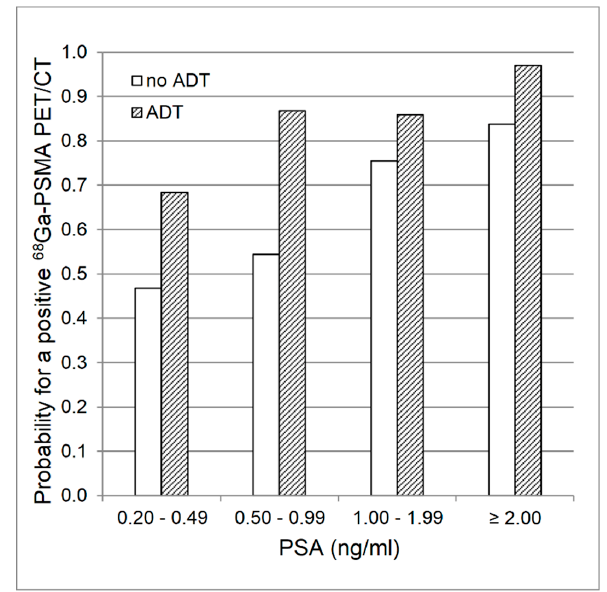
Figure 1. Logistic regression analysis. Estimated mean probability for a positive 68 Ga-PSMA ligand PET/CT finding with regards to PSA values and presence of androgen deprivation therapy (ADT).